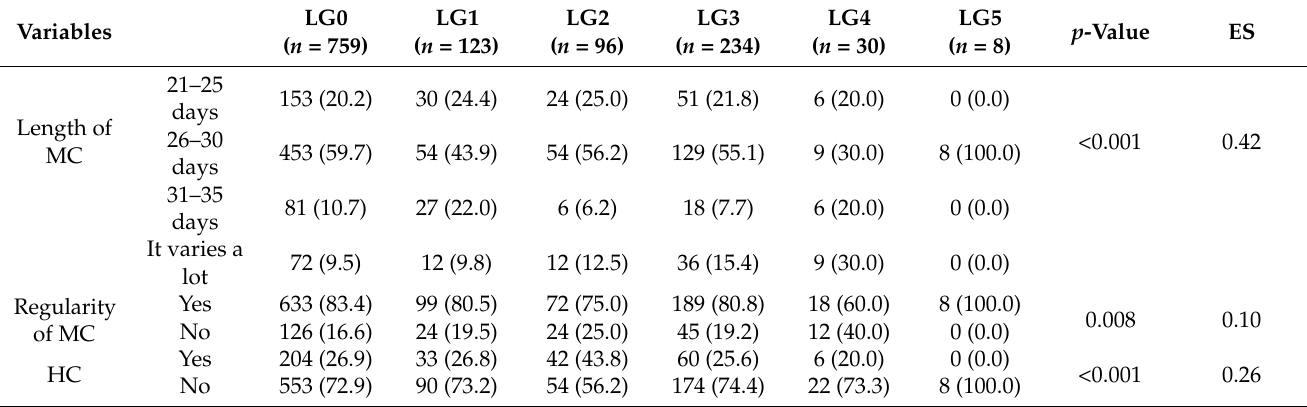
Table 2. Profile of the menstrual cycle (MC) related to different athletic